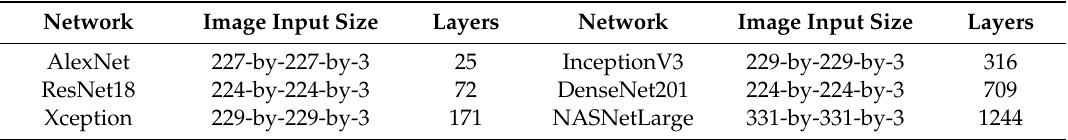
Table 2. The pretrained models with